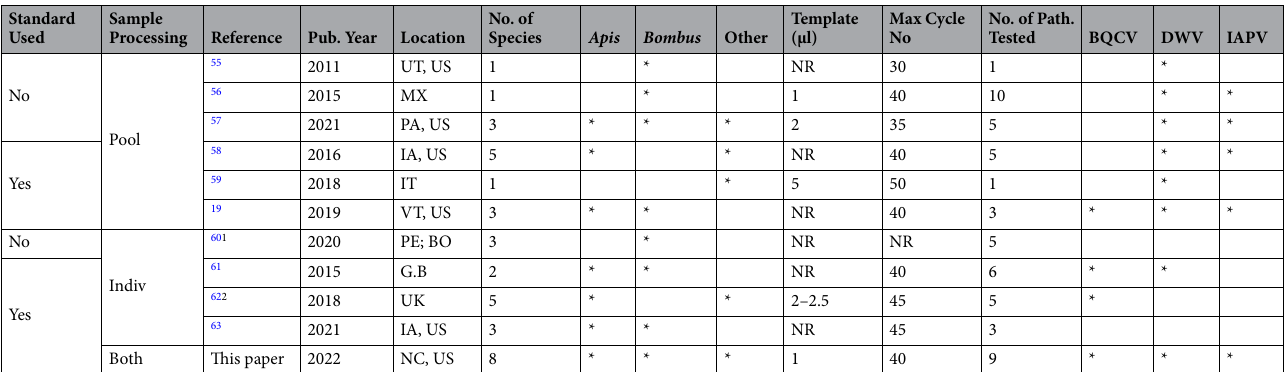
Table 2. Similar to Table 1, this table summarizes previous screenings of bees for interspecific pathogen detection. This table shows papers that used quantified PCR techniques only and notes if each paper included a standard curve during analysis. 1 This paper used qPCR. 2 This paper used RT-PCR for some targets and RT-qPCR for others.